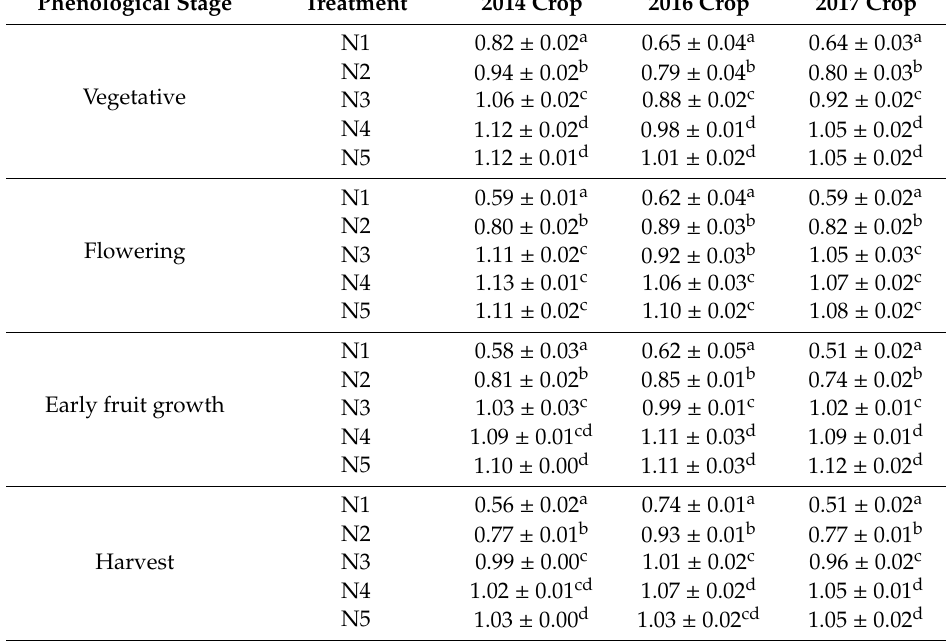
Table 2. Integrated nitrogen nutrition index ( NNIi ) values for each N treatment within each phenological stage in each of the three sweet pepper ( Capsicum annuum ) crops. Di ff erent lower-case letters (a–d) show significant di ff erences between N treatments within each phenological stage and crop, after the least significant di ff erence (LSD) post-hoc test of ANOVA. p -value < 0.001. Values are means (n = 4) ± standard error (SE). Each crop was subjected to five di ff erent N treatments with four